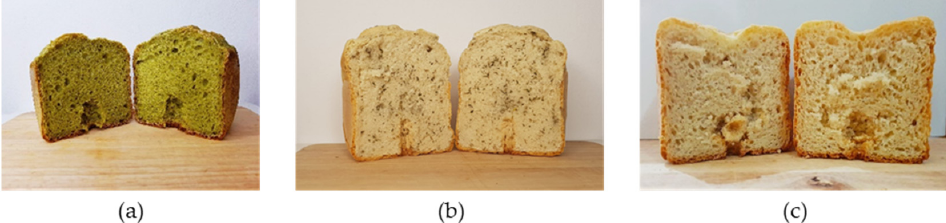
Figure 5. Pictures of the different cress-enriched model breads. ( a ) freeze-dried nasturtium ( Tropaeolum majus L, 4%) mixed into the dough (application No. I); ( b ) fresh garden cress ( Lepidium sativum L., 1.5%) mixed into the dough (application No. II); ( c ) reference bread without plant material.